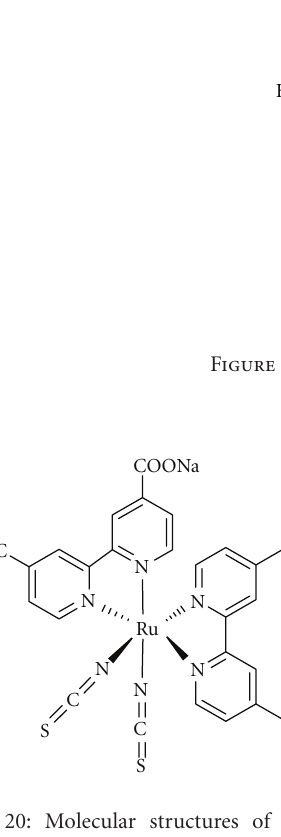
Figure 20: Molecular structures of the C101 (X = S) and C102 (X = O) sensitizers (taken from [38]).